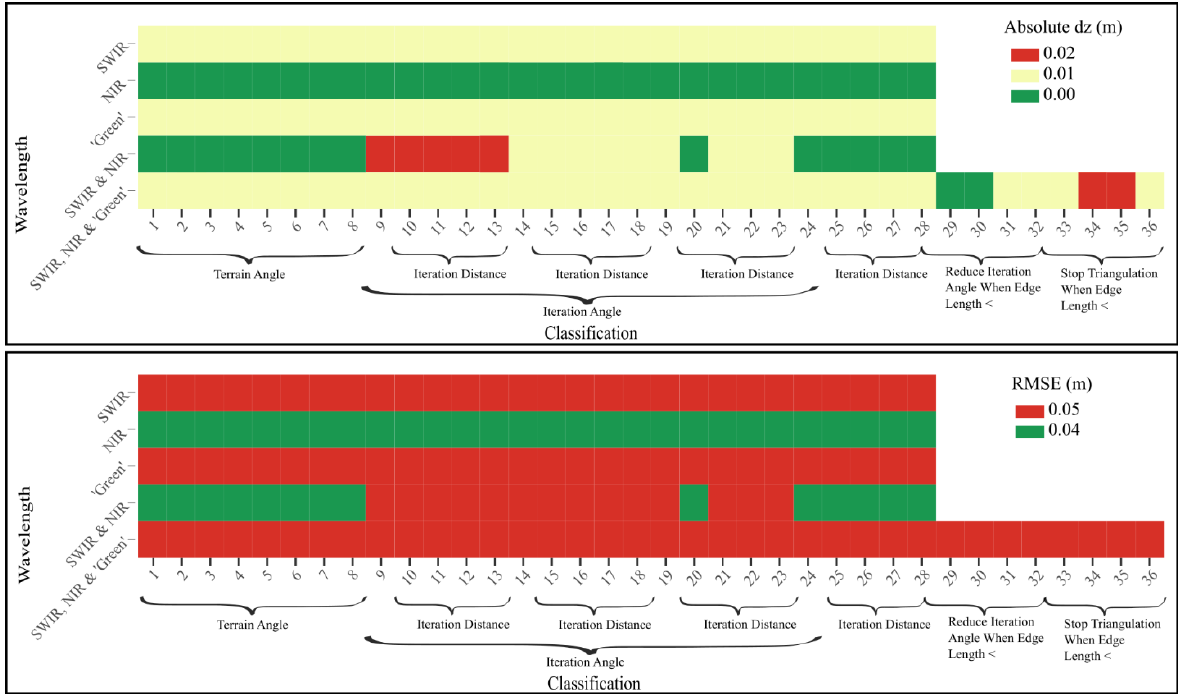
Figure 4 . Ground classification results (| 𝑑𝑧̅̅̅ | and RMSE) along a flat road surface for baseline comparisons using parameterization methods in Table 1. Classifications were conducted in TerraScan.